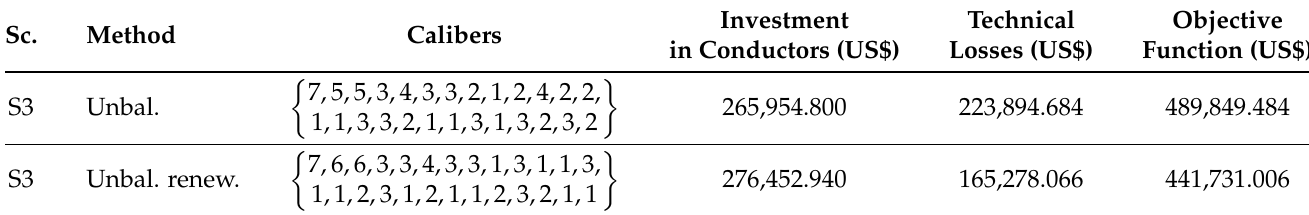
Table 28. Analysis of the 27-bus system with renewable